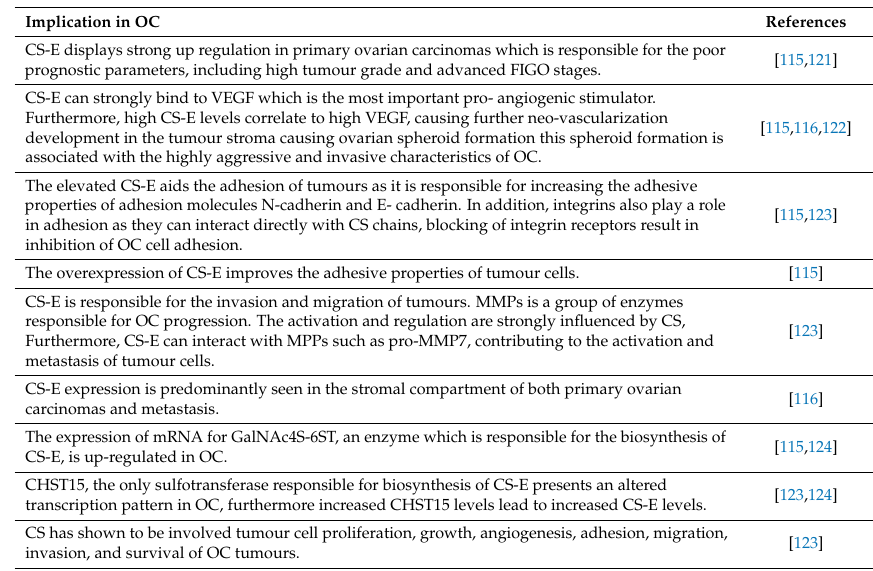
Table 3. The correlation of CS-E to OC, summarising and supporting CS-E as an important biomarker for OC diagnosis as well as a powerful molecular target for OC